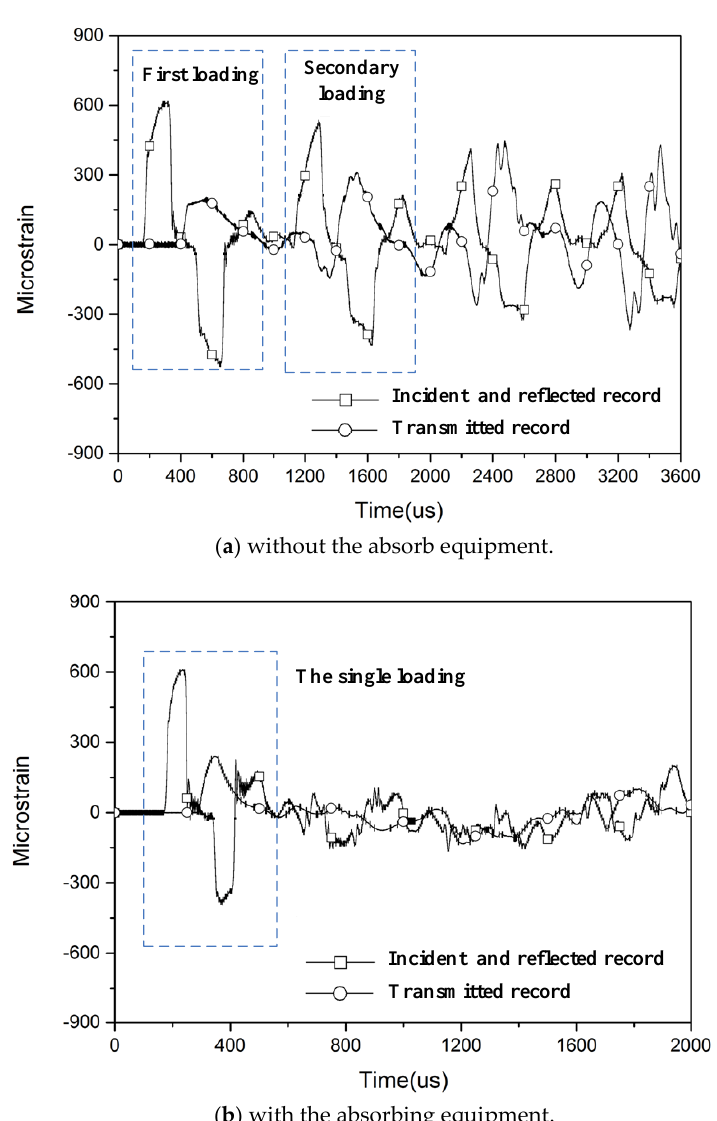
Figure 3. The typical signal at high strain rates.